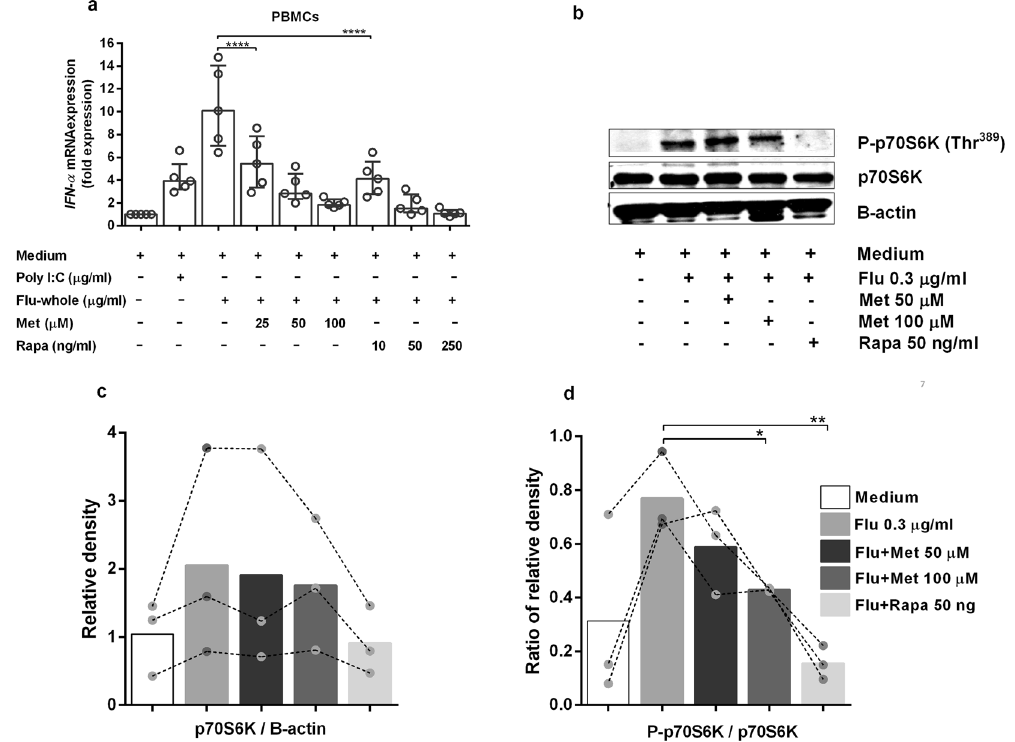
Figure 5. Metformin reduced IFN- α expression in primary human PBMCs via the mTORC1 pathway. (a) Peripheral blood mononuclear cells (PBMCs) from non-DM individuals (n = 5) were treated with metformin (Met) or rapamycin (Rapa) for 30 min. Drug-treated PBMCs were incubated with poly I:C or influenza whole- virion for 3 h before RNA extraction. IFN- α mRNA expression was determined by real-time PCR. Expression is shown as fold expression. Each point represents an individual. Statistical analyses were undertaken using one-way ANOVA. Horizontal lines represent the median and interquartile range. (b) The same PBMC samples were treated with Met or Rapa for 30 min before incubation with influenza whole-virion for 3 h, followed by determination of total p70S6k and P-p70S6K (Thr 389 ) by western blotting. The data are representative of three individuals. (c) Relative density of p70S6K. (d) Ratio of relative density of P-p70S6K/p70S6K. Each colour bar represents each condition. Each dot represents an individual. The bar graph represents mean values. Statistical analyses were carried out using two-way ANOVA, * p < 0.05, ** p < 0.01, **** p <